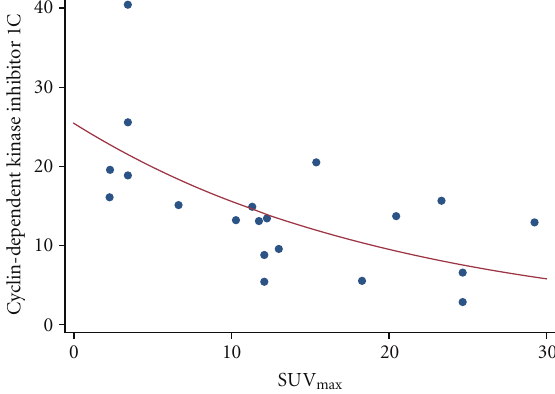
Figure 3: Correlation of the maximum SUV with cdki 1C ( r = 0 .